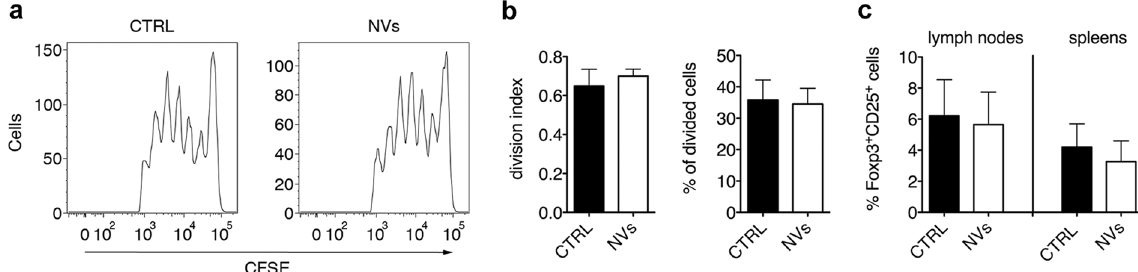
Figure 5. ASC-NVs do not impact CD4 + T cell activation in vivo in EAE mice. 15 × 10 6 -CFSE labeled lymph node and spleen cells from 2D2 mice were injected 8 dpi in EAE recipient mice previously treated with two PBS (CTRL) or ASC-NV injections at 3 and 8 dpi. ( a ) Representative plots from one control and one NV-treated mouse showing the proliferation of exogenous CD4 + CFSE + T cells detected as CFSE dilution from the original T cell population. ( b ) Samples were analyzed with FlowJo software to quantitatively assess T cell proliferation in recipient mice. No differences were observed between the proliferation of exogenous CD4 + T cells in control or NV-treated animals. Data are the mean ± SD of five mice/condition. ( c ) Quantification of Foxp3 + CD25 + regulatory T cells (Tregs) in draining lymph nodes and spleens of EAE mice. Lymph nodes and spleens were collected at disease peak from EAE mice treated with PBS (CTRL) or ASC-NVs at day + 3, + 8 and + 13 post- immunization (preventive treatment). Treatment with NVs did not impact the amount of Tregs in both lymph nodes and spleens. Data are shown as % of Foxp3 + CD25 + Tregs on the total CD3 + CD4 + T cell population and are the mean ± SD of 4 mice/condition.